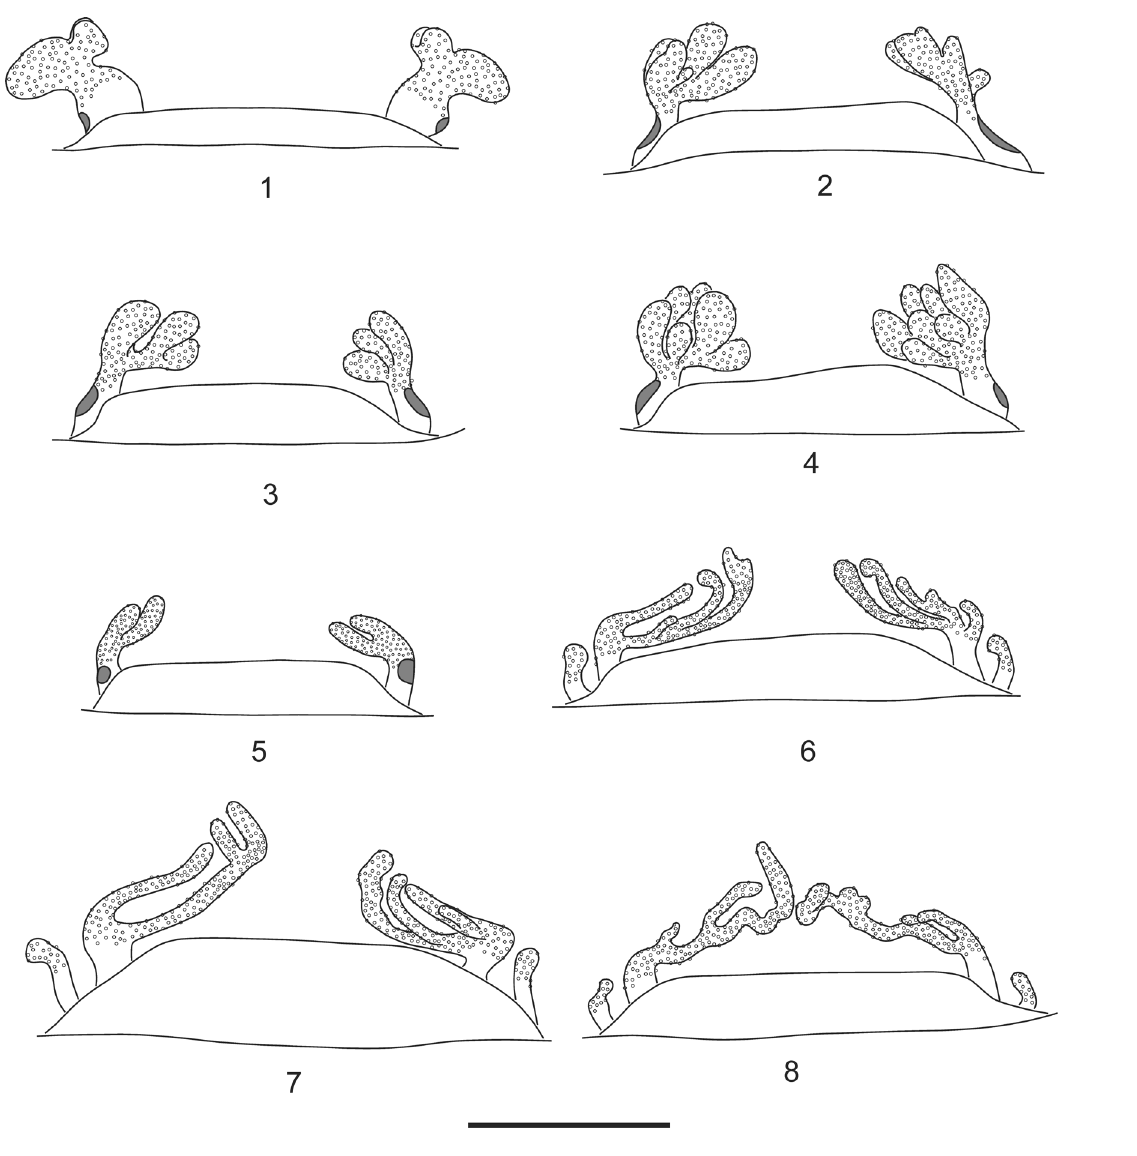
Figs 1–8. Female internal genitalia. 1 . Hexophthalma binfordae sp. nov. 2–4 . H.